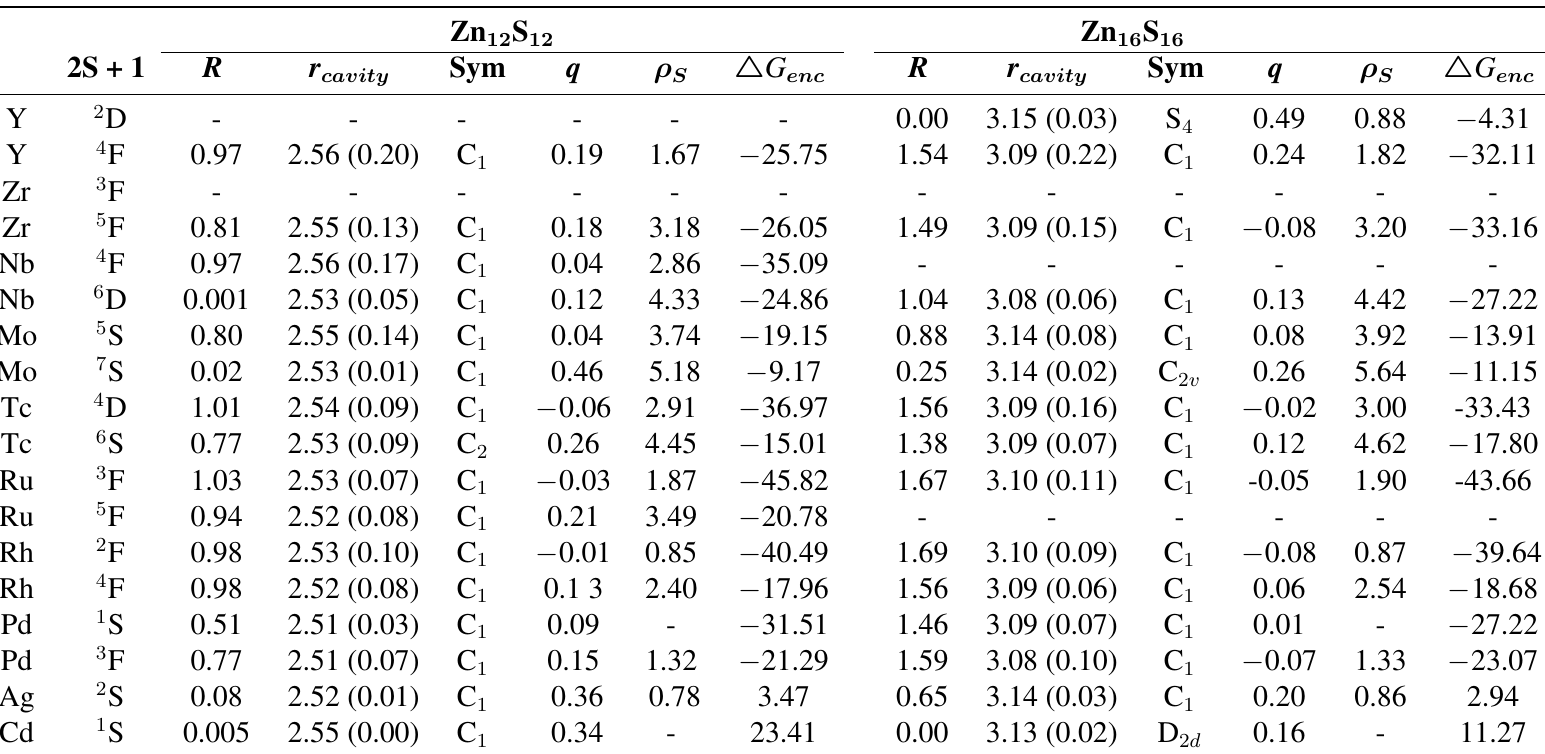
Table 1. R stands for the distance of the TM with respect to the center of the clusters and r is the cavity radius of the cluster cavity (standard deviation in parentheses), in ˚ A. The charge ( q ) and the spin density ( ρ ) is the transition-metals are given along with the x S encapsulation free energy, (cid:52) G enc